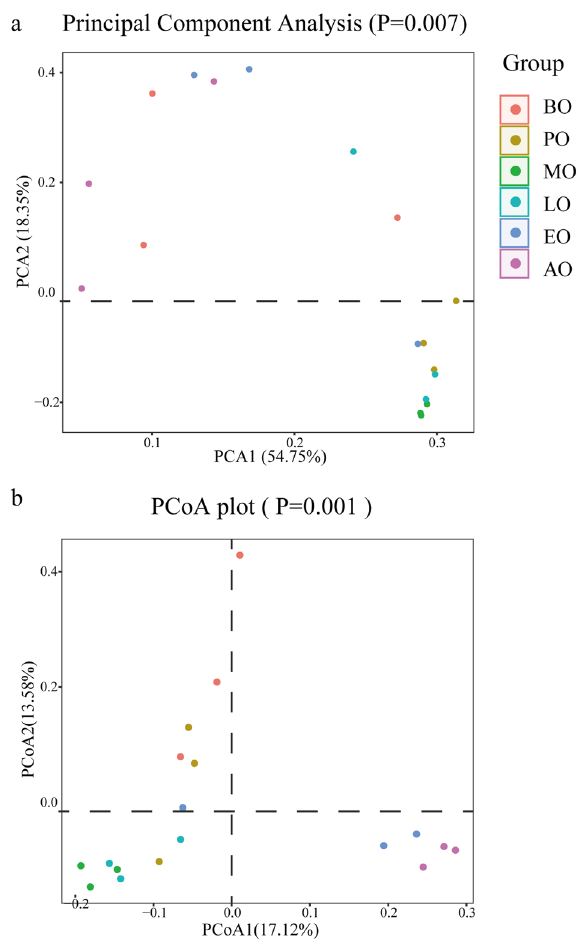
Figure 5. The PCA ( a ) and PCoA ( b ) plots of jackknifed unweighted UniFrac distances. Different colors represent different groups. Each axis explains the percentage of variation.